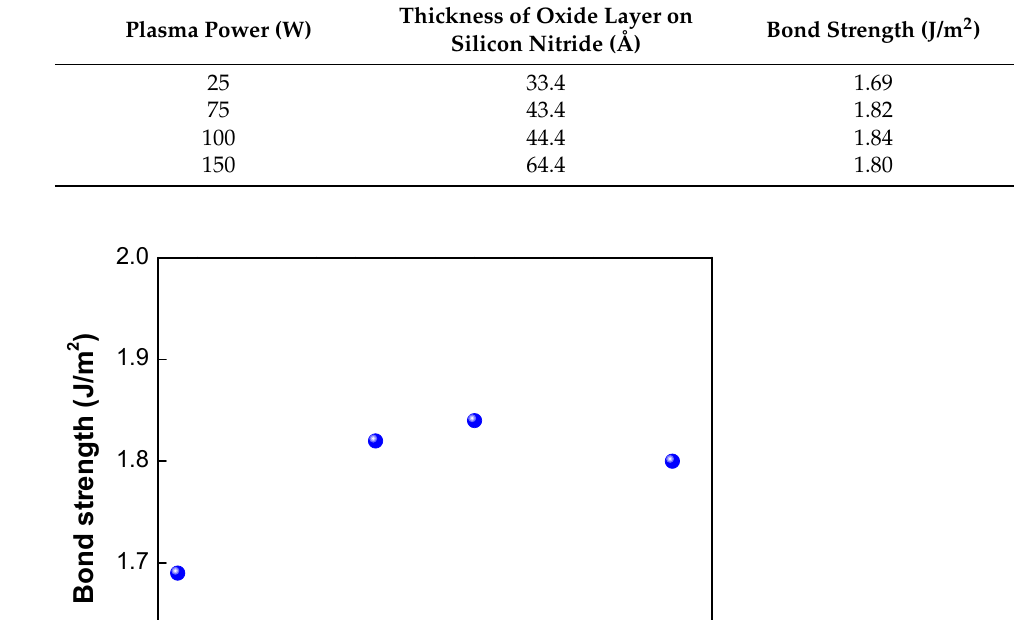
Figure 7. Changes in Rmax under different low plasma powers. The abrasive slurry particles used in the CMP process also play a very important role in determining the surface roughness of the wafer surface. As shown in Figure 8, as the size of the abrasive particles decreased, the surface roughness of the wafer was reduced. As discussed in the literature [21], there are many nanogaps or asperities that exist on the wafer surface. These nanogaps or asperities are one of the main sources of void formation and decrease in bond strength. Therefore, the bond strength could be improved by using smaller abrasive particles due to the greater nanogap closing effect and elimination of the asperities on the surface. In summary, the use of O 2 plasma gas and smaller abrasive particles will enhance the bond strength. The increase in the plasma power will also increase the bond strength by increasing the oxide growth rate. However, the much higher plasma power will instead increase the surface roughness, resulting in lower bond strength. Therefore, the proper selection of the plasma power is necessary to increase the bond strength.